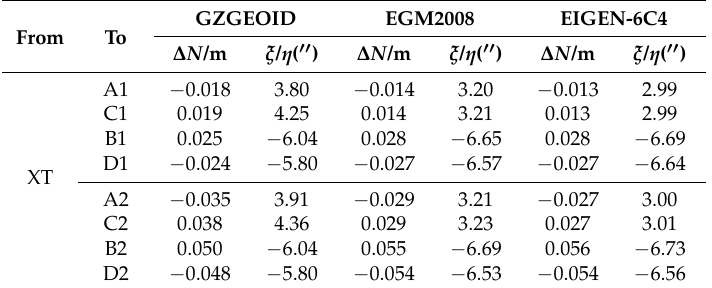
Table 7. The deflection of vertical components from the GZGEOID, EGM2008, and EIGEN-6C4 models.